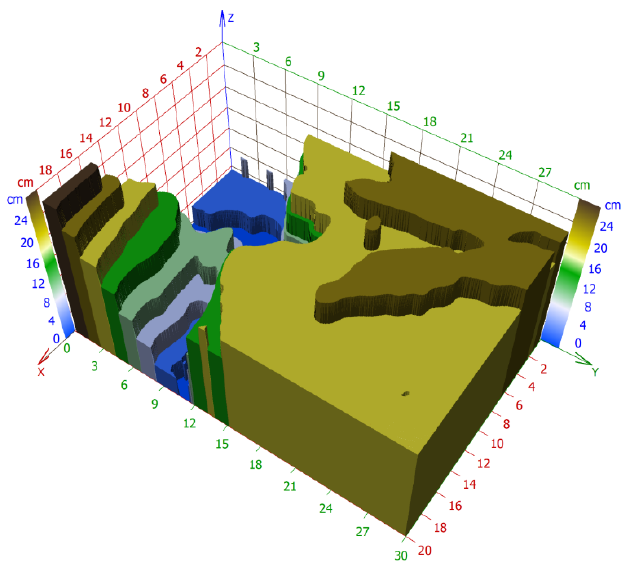
Figure 13. A 3D echelon approximation of the limestone sample by the optical cuts used in Figure 11. The software was written by the first author. Taken from [45].